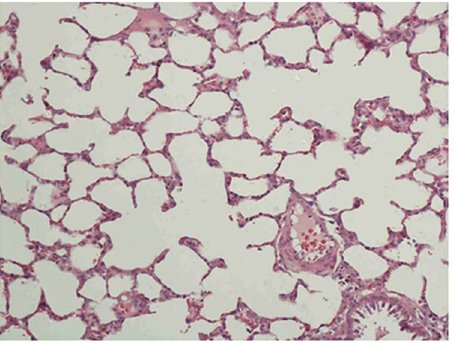
Figure 1. HE stain of control group ( 6 200). Lung tissue is normal. The alveolar space has a normal interstitium structure and no effusion. PLOS ONE |